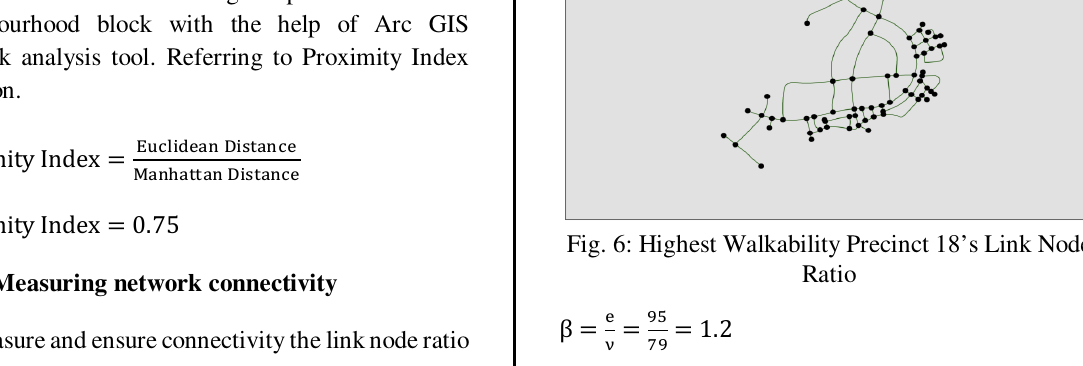
Fig. 6: Highest Walkability Precinct 18’s Link Node # 56 β = = = 4 75